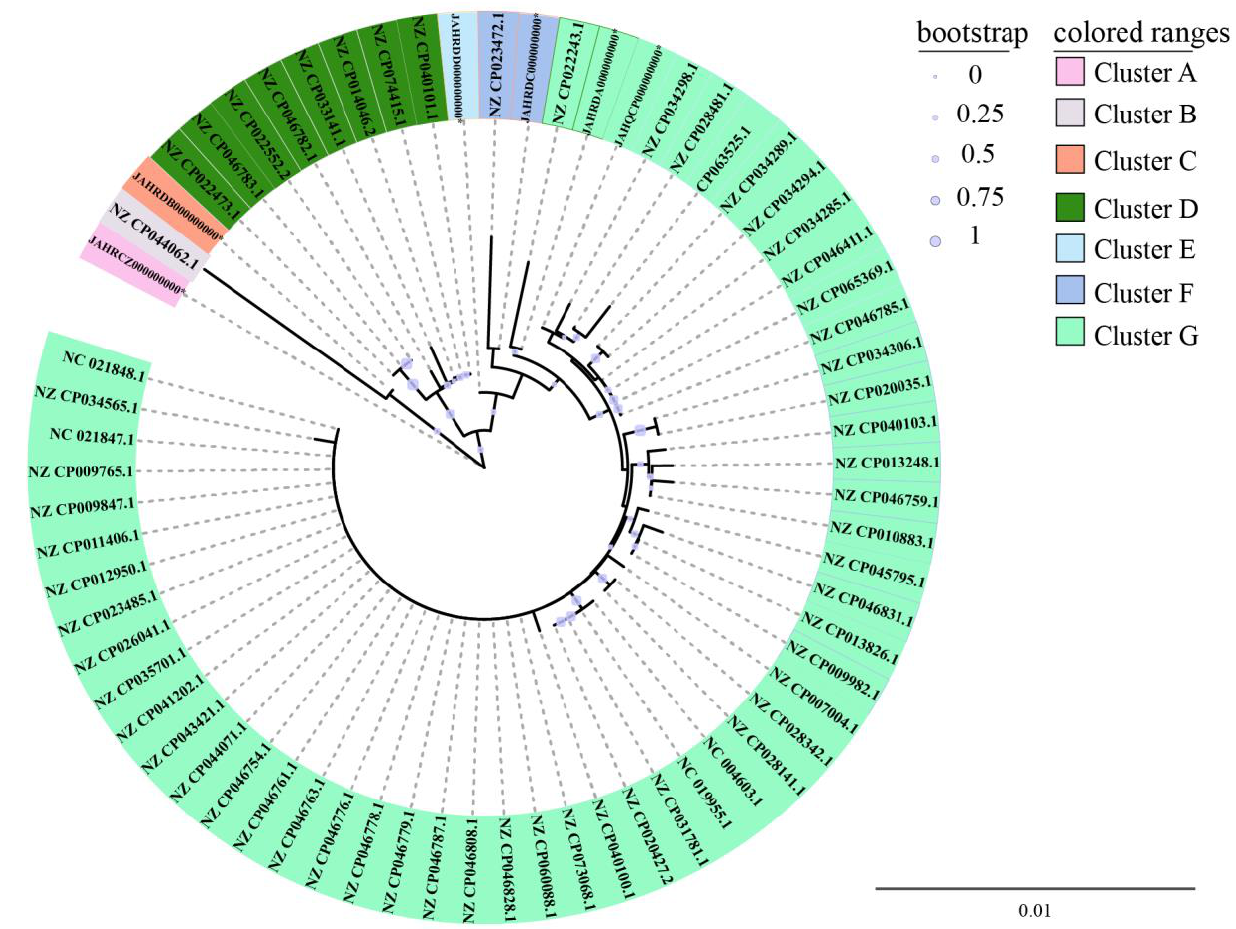
Figure 4. Phylogenetic tree showing the relationship of the 69 V. parahaemolyticus genomes. Complete genome sequences of the 63 V. parahaemolyticus isolates were retrieved from GenBank database with accession numbers showed in the tree. *: genome sequences of the six V. parahaemolyticus isolates determined in this study. The phylogenetic tree was constructed using the maximum likelihood approach with 1000 bootstrap replications, and the cutoff threshold for bootstrap values was above 50%. 3.5. Diverse MGEs in the Six V. parahaemolyticus Genomes of Edible Aquatic Animal